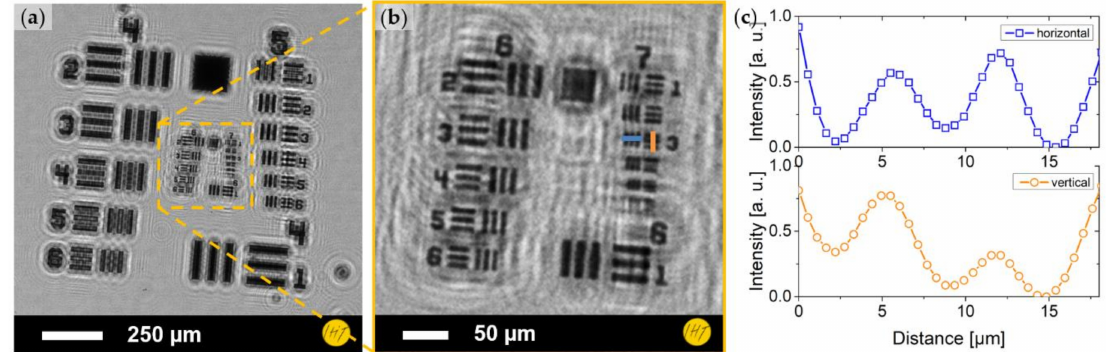
Figure 4. Holographic image of 1951 USAF resolution test chart: ( a ) view of Groups 4 and 5 of the chart; ( b ) enlarged view of Groups 6 and 7; and ( c ) normalized intensity profile through Element 3 of Group 7 (horizontally and vertically, see colored bars in ( b